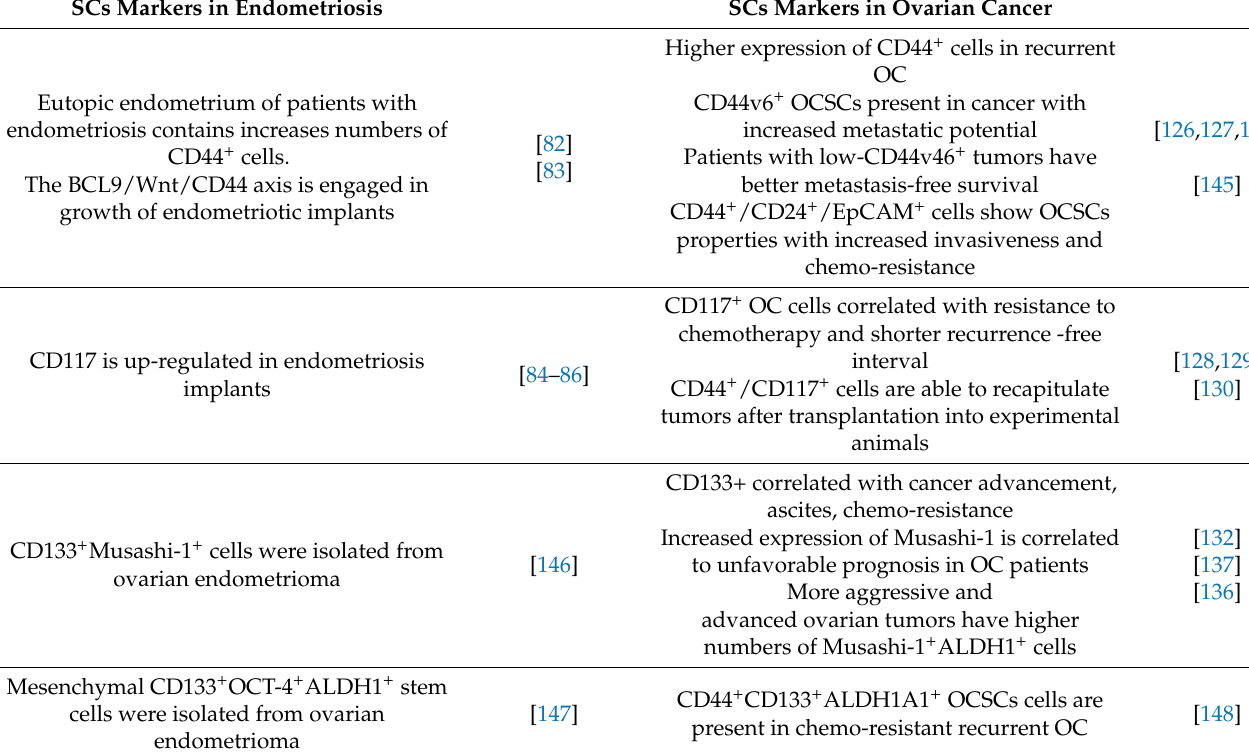
Table 1. Stem cells in endometriosis and ovarian cancer and their role in both pathologies. SCs Markers in Endometriosis SCs Markers in Ovarian